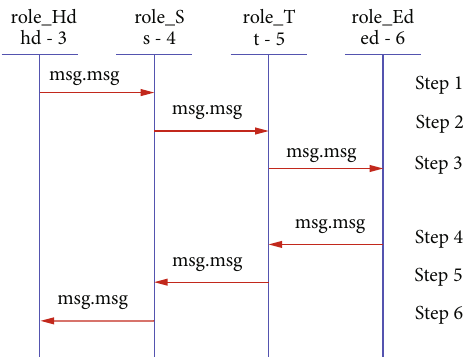
Figure 11: Edge device role speci fi cations.